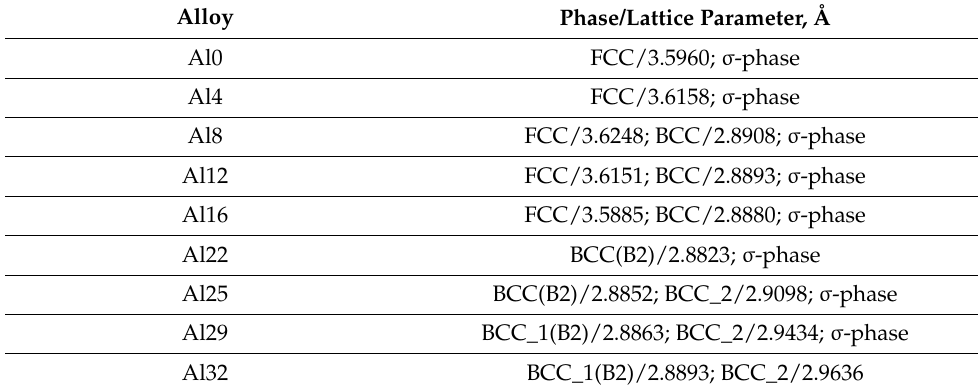
Figure 1. XRD patterns of the FeNiCoCrMo 0.5 Al x . Table 2. Phase found by XRD.